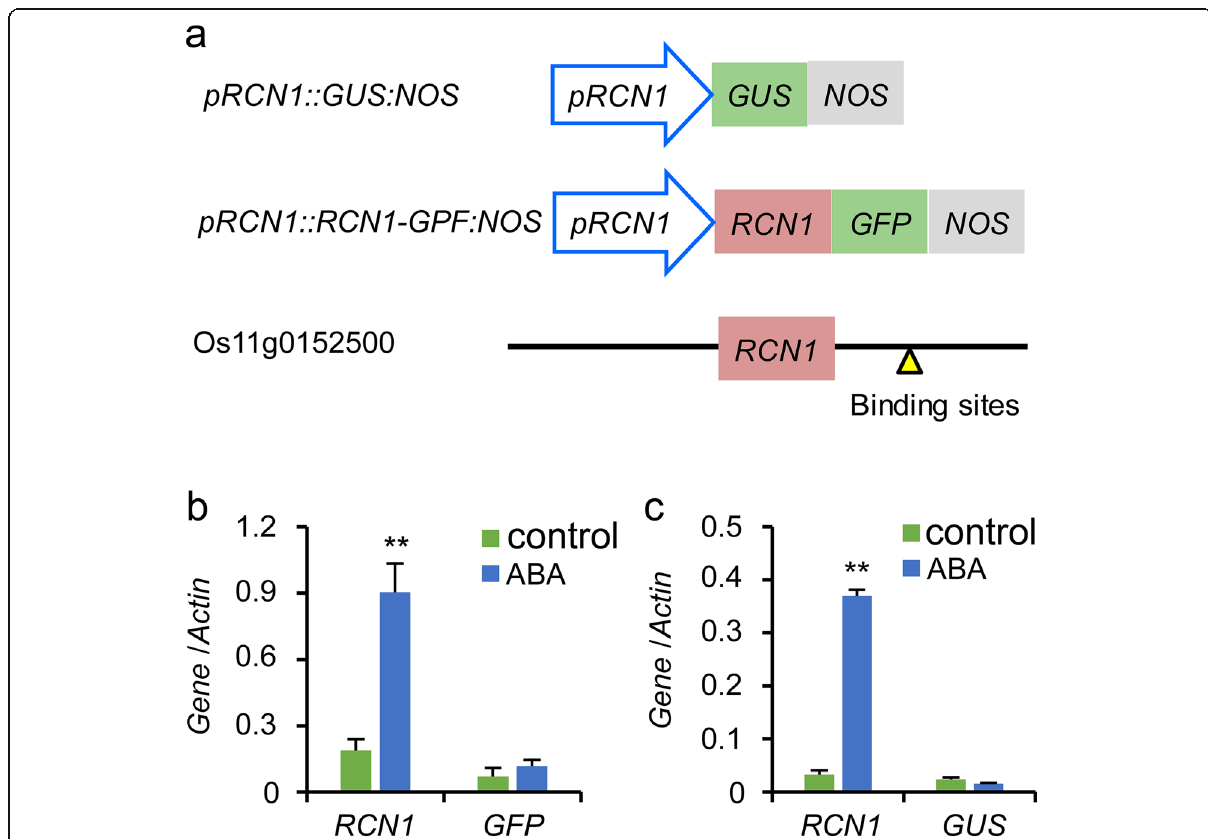
Fig. 5 Differences in promoters and terminators in pRCN1::GUS:NOS and pRCN1::RCN1-GFP:NOS transgenic plants and wild-type (WT) plants ( a ). The expression levels of native RCN1 and GUS in the pRCN1::GUS:NOS transgenic plants under ABA treatment ( b ). The expression levels of native RCN1 and GFP in the pRCN1::RCN1-GFP:NOS transgenic plants under ABA treatment ( c